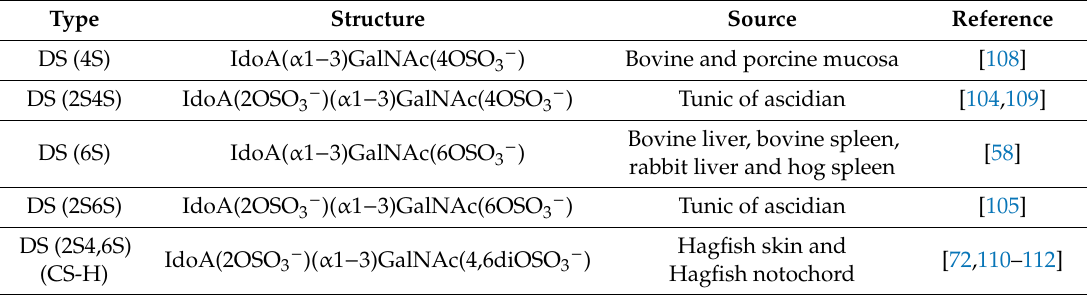
Table 2. Common and novel DS (CS-B) disaccharide units described by sulfation patterns and by common